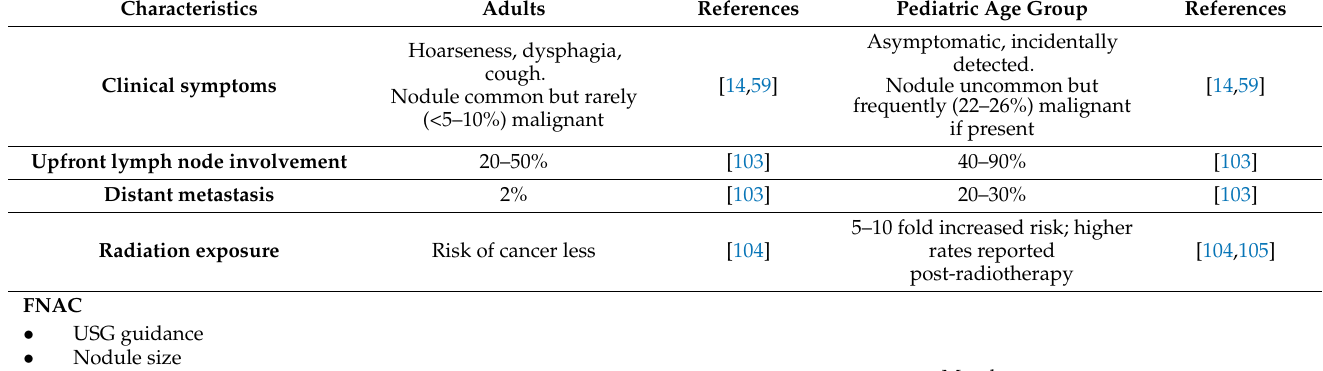
Table 1. Clinical, pathological and molecular characteristics of adult and pediatric thyroid